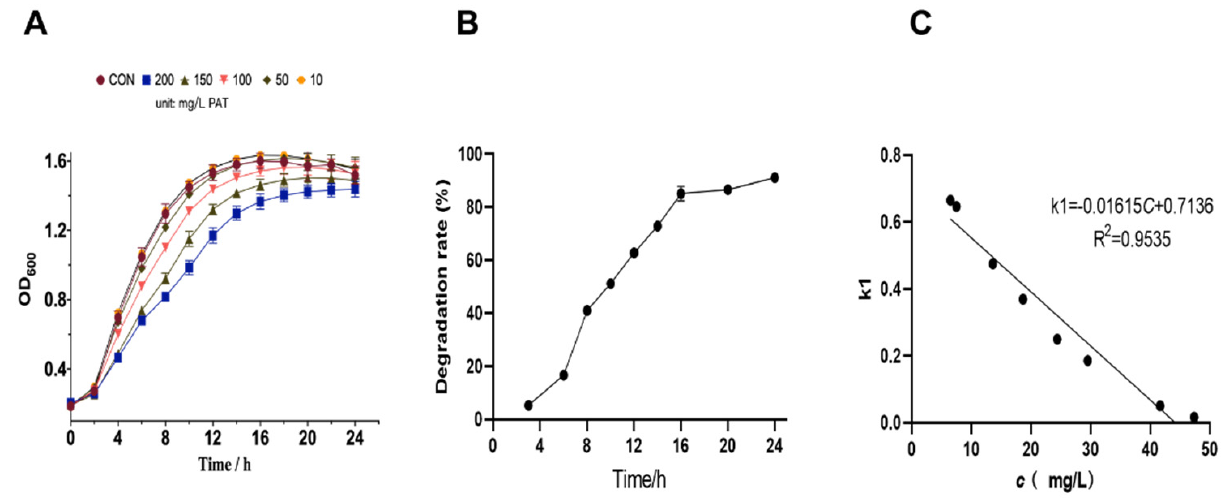
Figure 1. Growth curve of Lactiplantibacillus plantarum CCFM1287 under PAT stress ( A ). Biodegra- dation of PAT by L. plantarum CCFM1287 in MRS medium ( B ). Kinetic fitting results. ( C ).